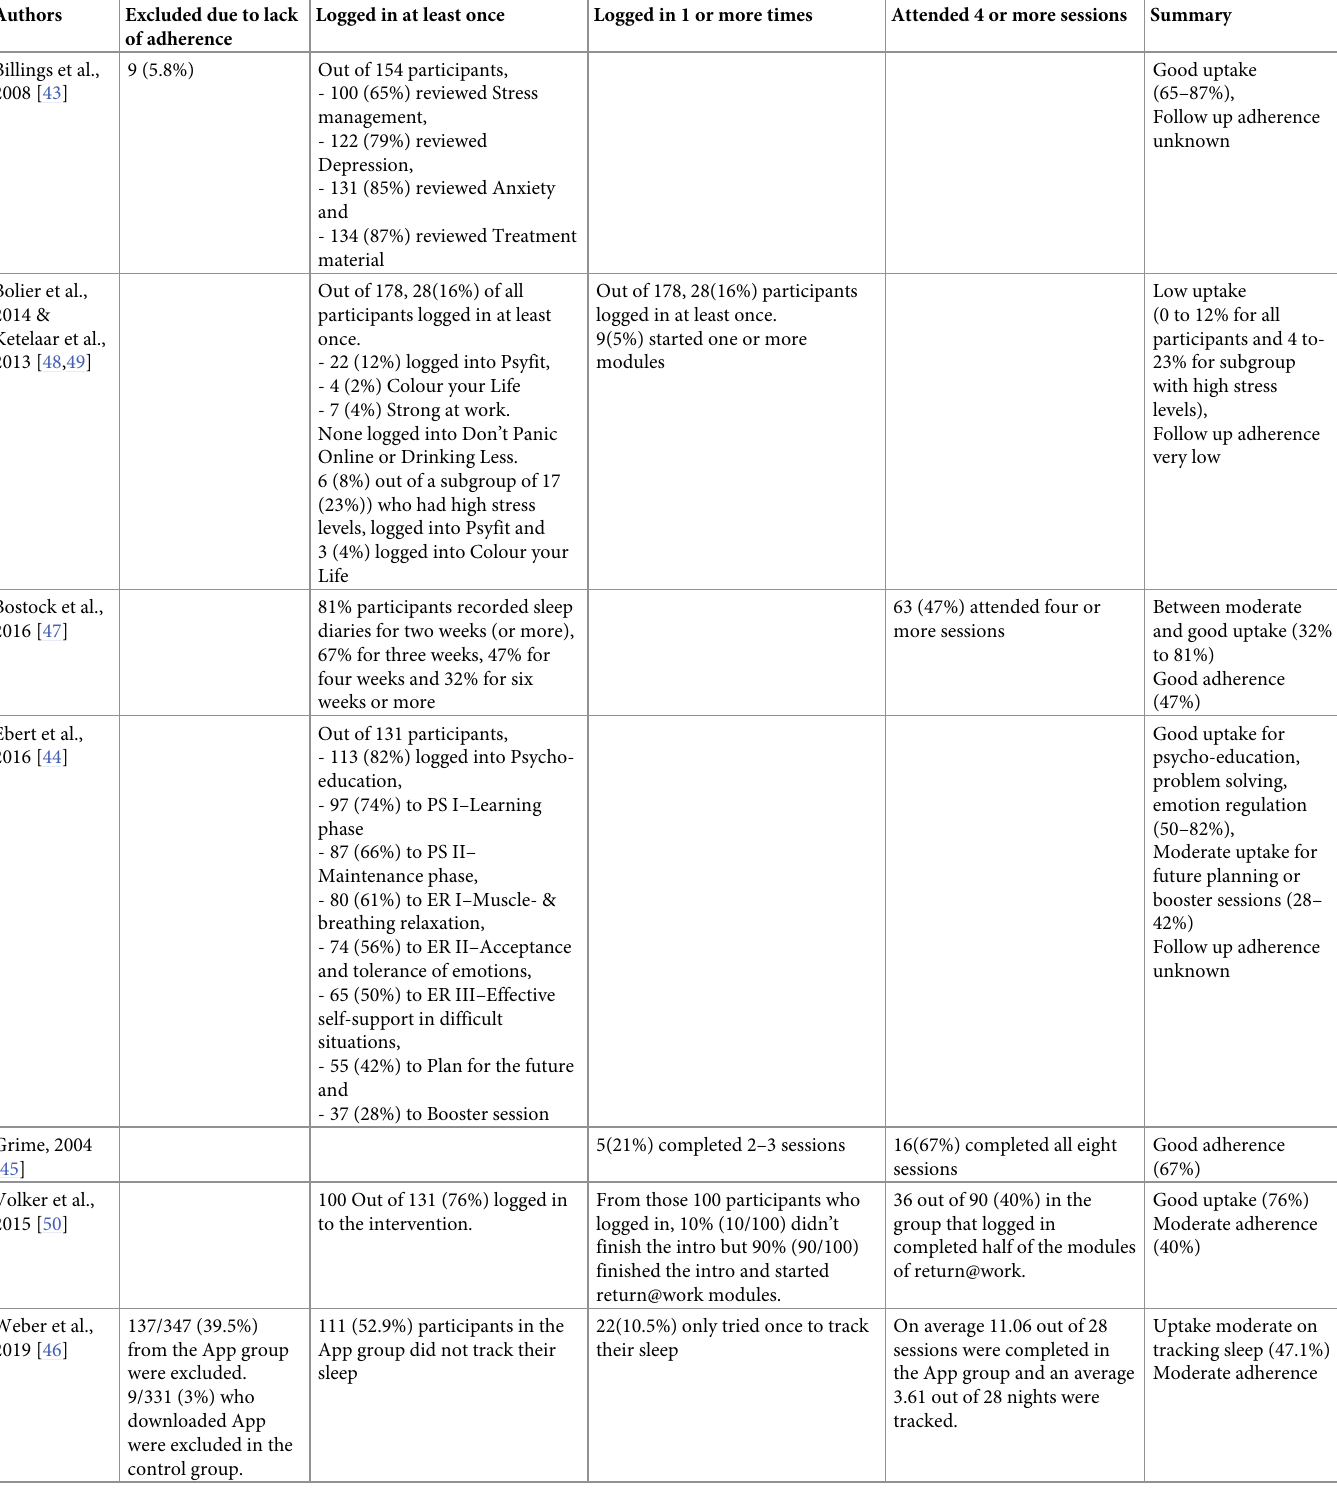
Table 5. Adherence and